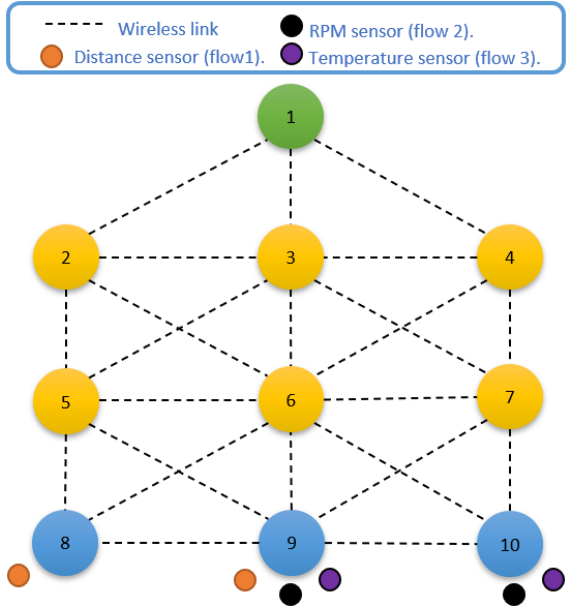
Figure 3. Topology with 10 fixed